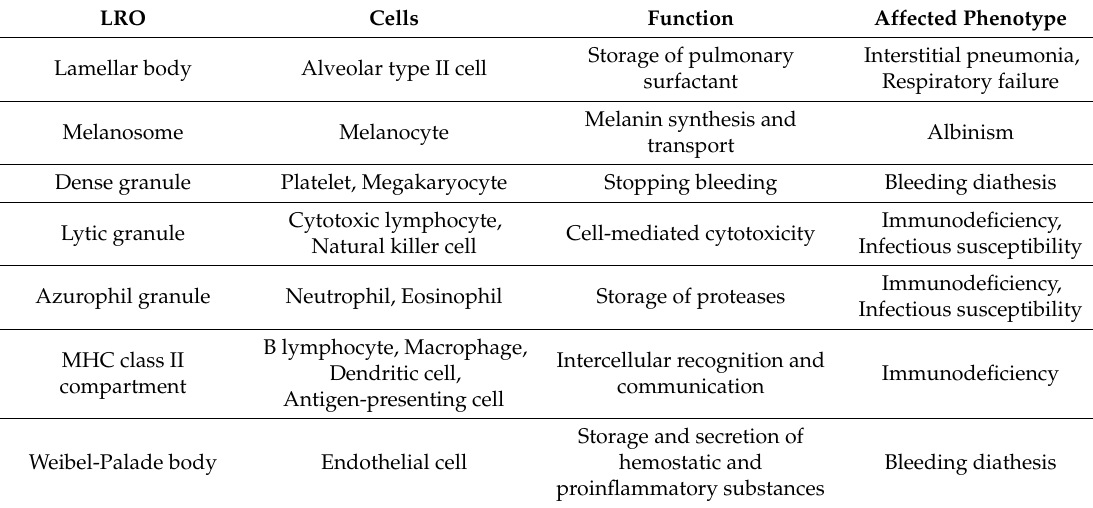
Table 2. Representative lysosome-related organelles